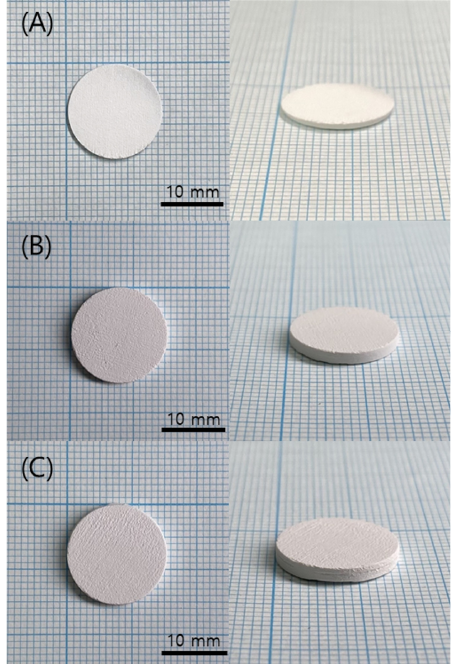
Figure 7. Green body specimens according to various chamber temps: ( A ) 15 °C; ( B ) 40 °C; ( C ) 60 °C.